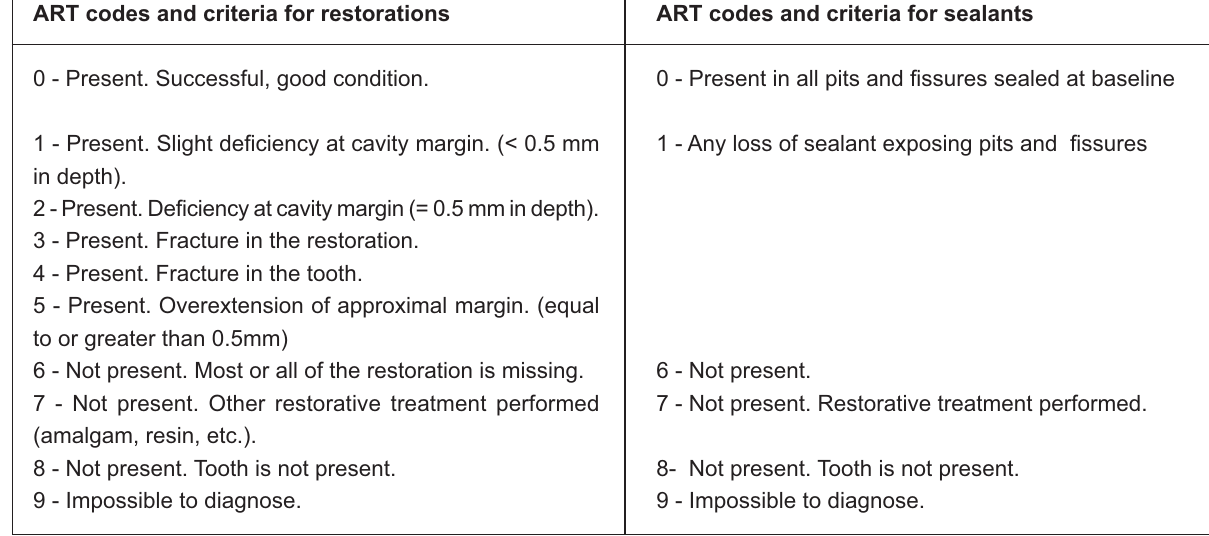
Figure 2- ART codes and criteria for restorations and